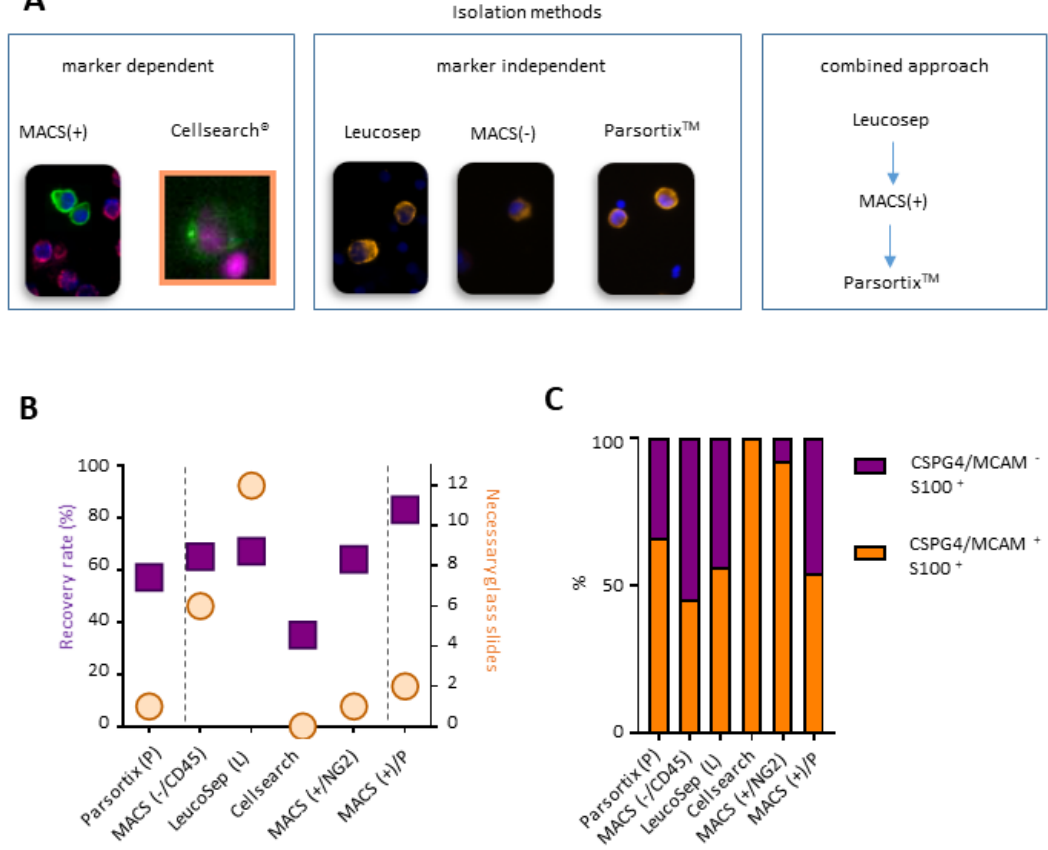
Figure 2. Method to analyze melanoma cell subsets. ( A ) Tested isolation methods for the membrane marker dependent and independent enrichment of melanoma cells. ( B ) Recovery rate of 50 melanoma cells in 7.5 mL of blood and subsequent histological slides needed for analysis. ( C ) Amount of melanoma cells positive for membrane markers CSPG4/MCAM and intracellular S100. N = 3–4.